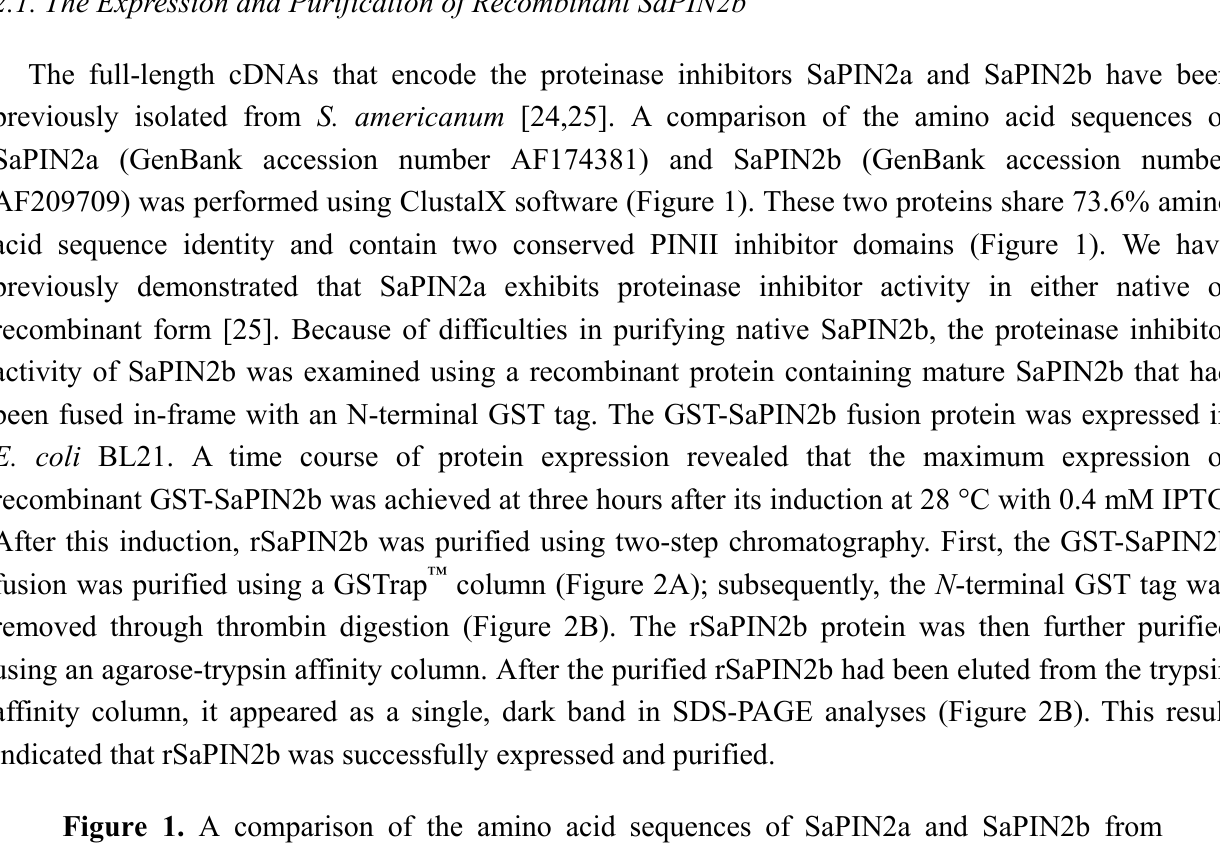
Figure 1. A comparison of the amino acid sequences of SaPIN2a and SaPIN2b from Solanum americanum . The sequence alignment was performed using ClustalX software [29], and the sequences were subsequently adjusted using GeneDoc software. The shaded blocks indicate consensus sequence motifs. The horizontal arrows indicate PINII inhibitor domains, which were explored using the Pfam databases